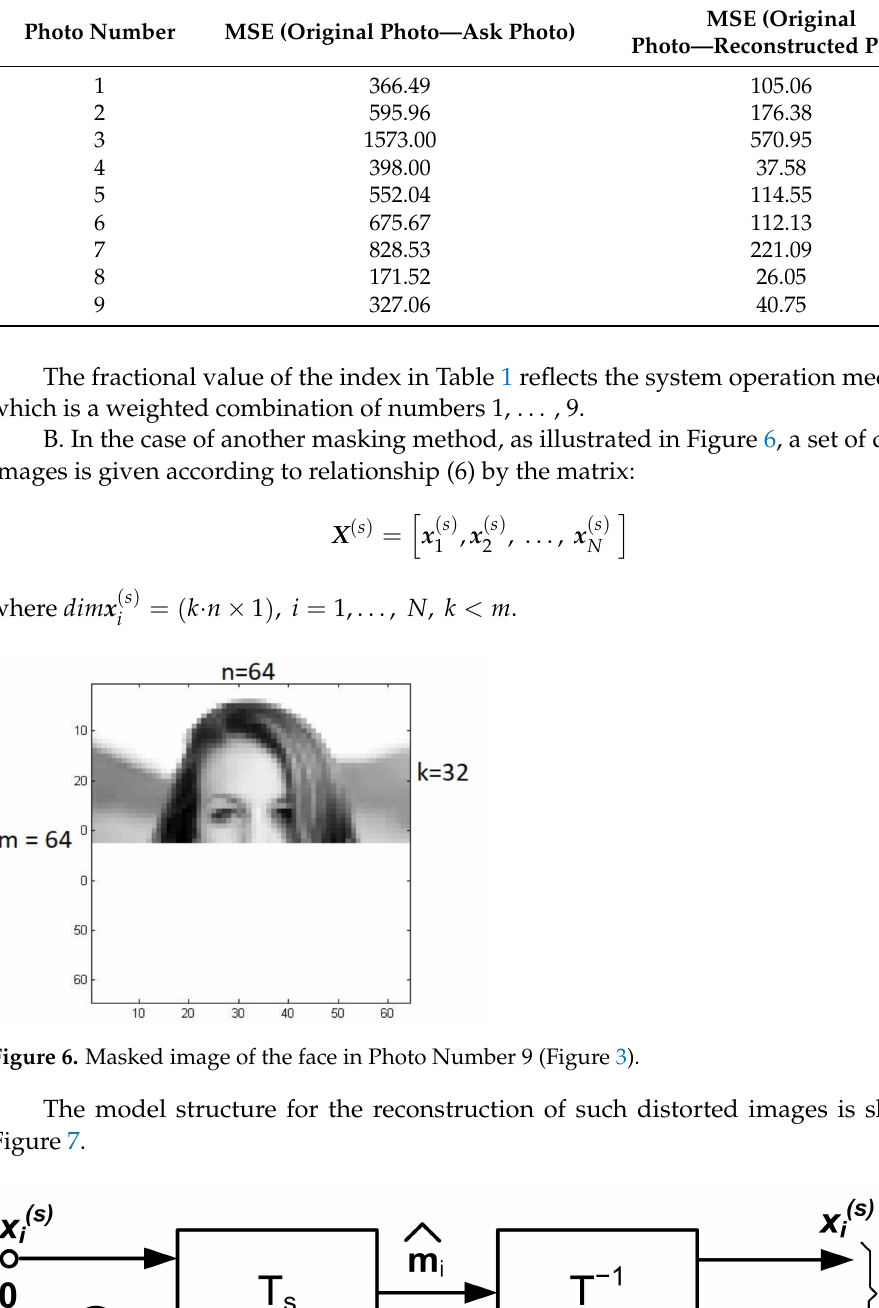
Table 3. Values of the Recognition Index of each person.